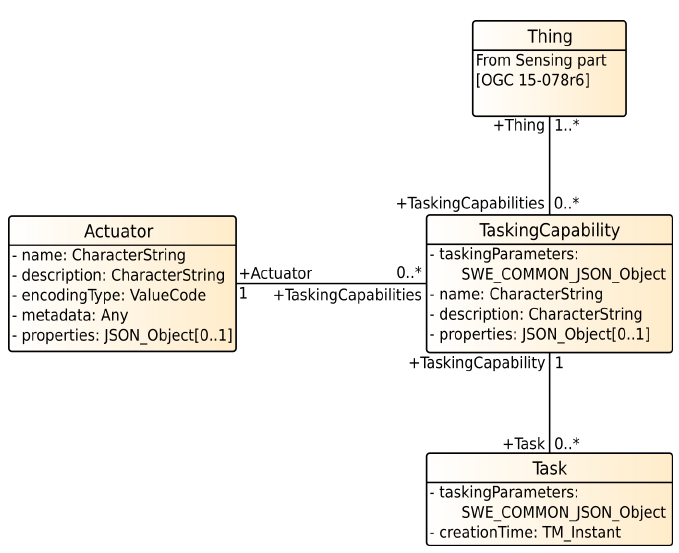
Figure 3. SensorThings API tasking data model